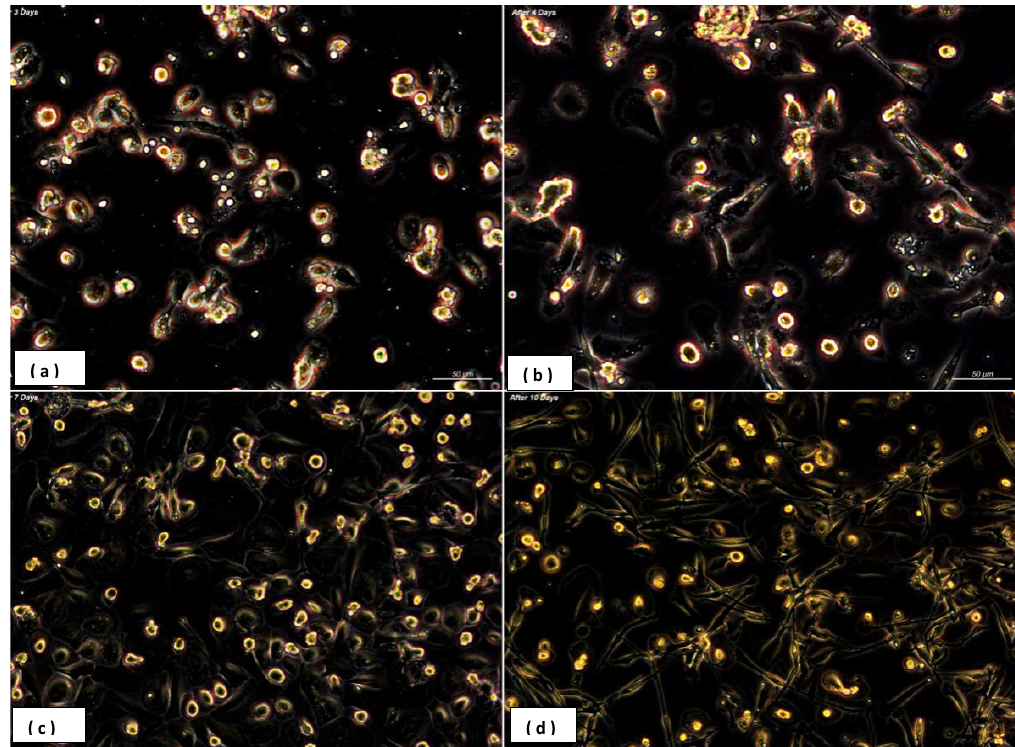
Figure 2. Monocyte-derived macrophages presented a unique morphology dependent on performed stimulatory e ff ect. Granulocyte / macrophage colony stimulating factor (GM-CSF) led to a majority of elongated, fibroblast- spindle like shaped cells ( c ), and ( d ) similar to macrophages existent in lung alveoli, in contrast the presence of macrophage colony-stimulating factor (M-CSF) induced a majority of round or oval macrophages (fried eggs) like peritoneal macrophages (Axio observer Z1, Zeiss-AxioCamMR5 resolution 100 × ) ( a , b ). Human monocytes were cultured in RPMI-1640 with 20% heat-inactivated fetal calf serum supplemented with 5 ng / mL GM-CSF (granulocyte-macrophage colony-stimulating factor) and 5 ng / mL M-CSF (macrophage colony- stimulating factor). Monocytes were di ff erentiated for 10 days in the presence of M-CSF and GM-CSF cytokines. ( a ) At day 3, ( b ) at day 4 and ( c , d ) at day 7 and 10. After seven days monocytes di ff erentiated into macrophages.